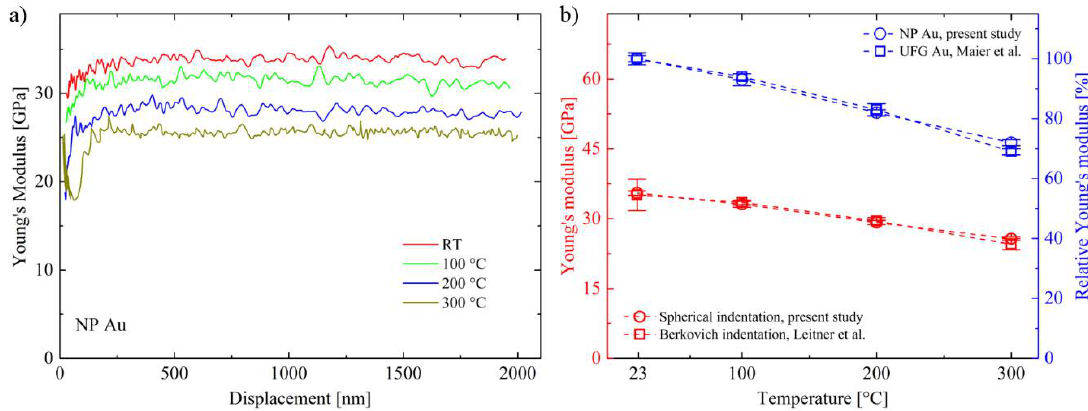
Figure 3. ( a ) Young’s modulus profiles of spherical HT nanoindentation tests up to 300 °C. The absence of significant gradients indicates reliable measurements at all temperatures; ( b ) The